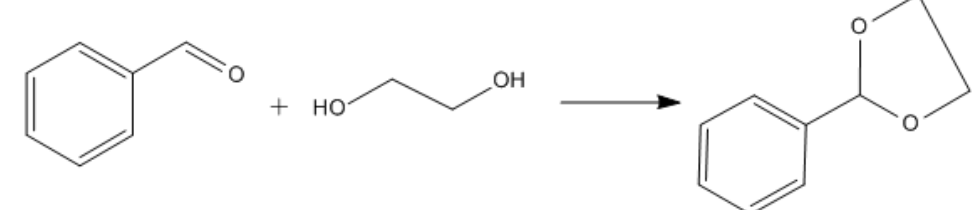
Figure 7. Reaction of benzaldehyde condensed with ethylene glycol.